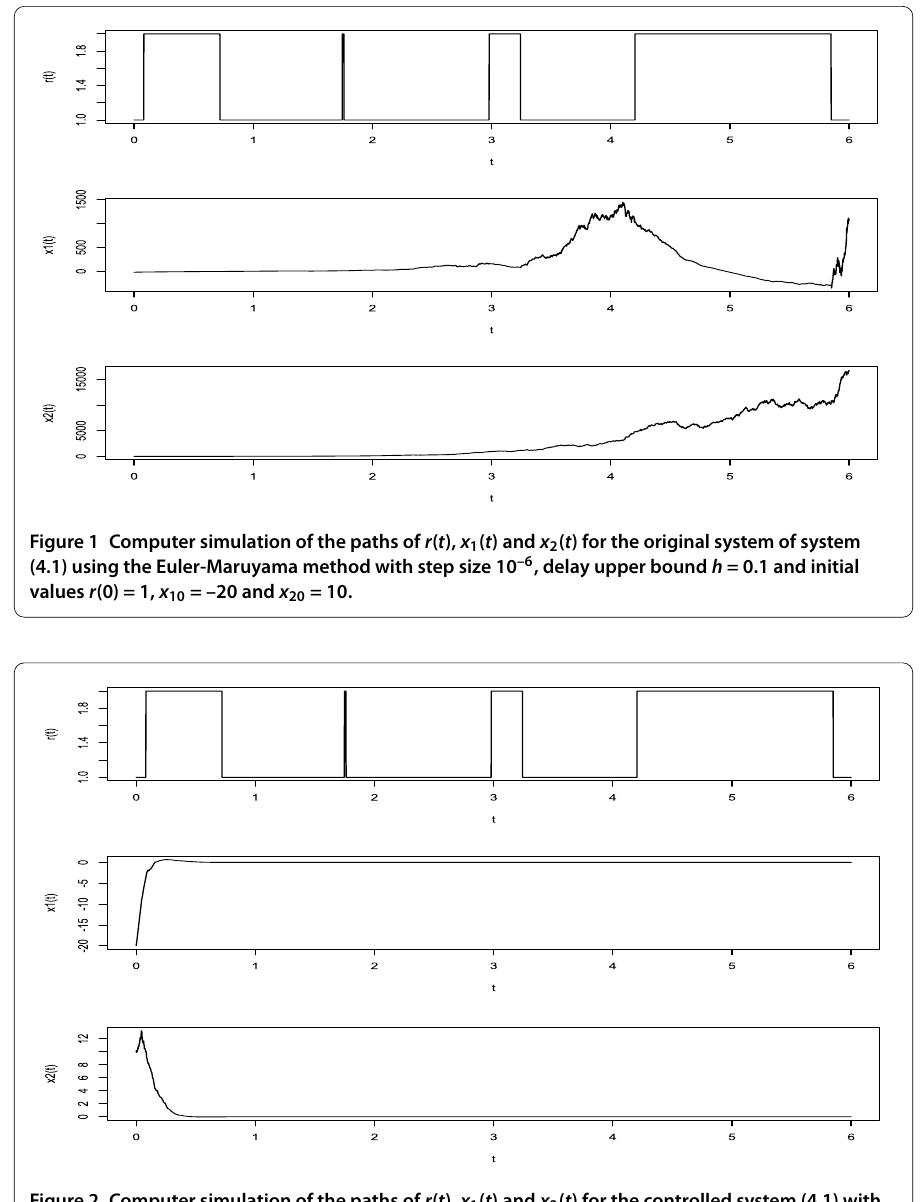
Figure 2 Computer simulation of the paths of r ( t ), x 1 ( t ) and x 2 ( t ) for the controlled system (4.1) with τ = 0.016 using the Euler-Maruyama method with step size 10 –6 , delay upper bound h = 0.1 and initial values r (0) = 1, x 10 = –20 and x 20 =